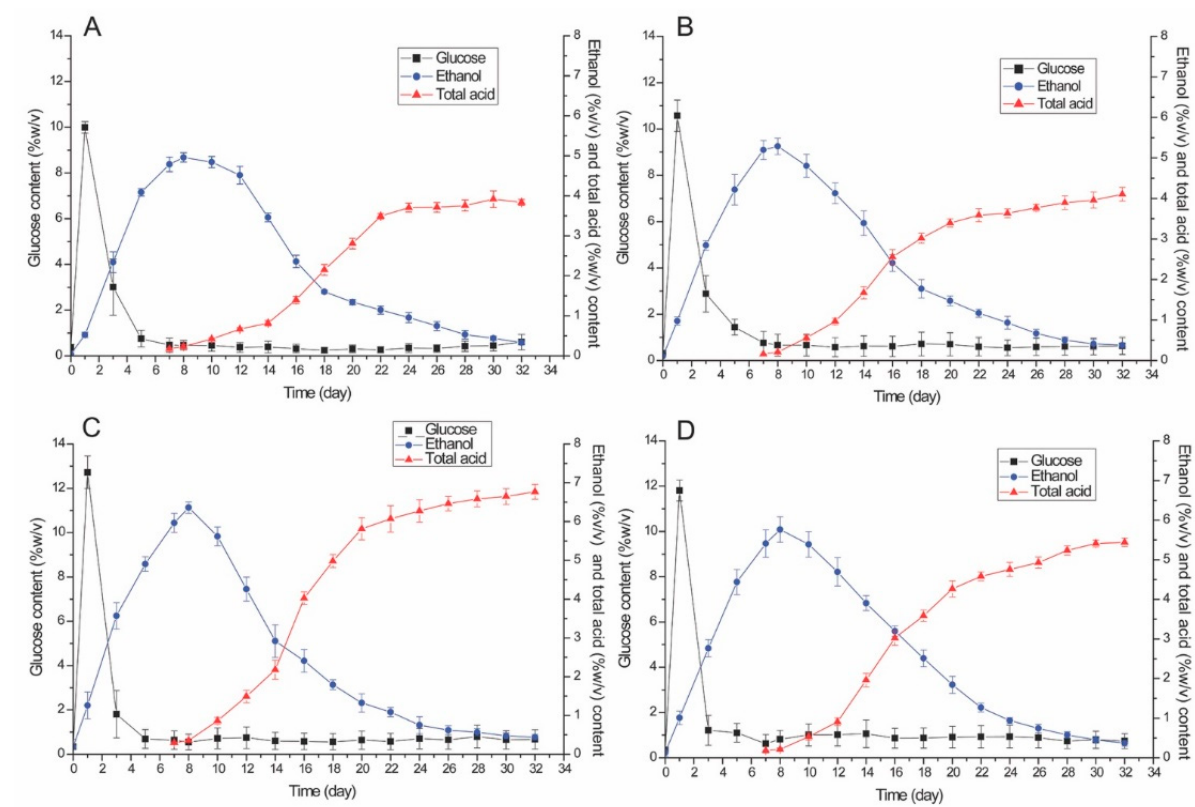
Figure 2. Total acid content in fermented broth of polished rice ( A ), black fragrant rice ( B ), glutinous rice ( C ) and black glutinous rice ( D ) during vinegar fermentation.